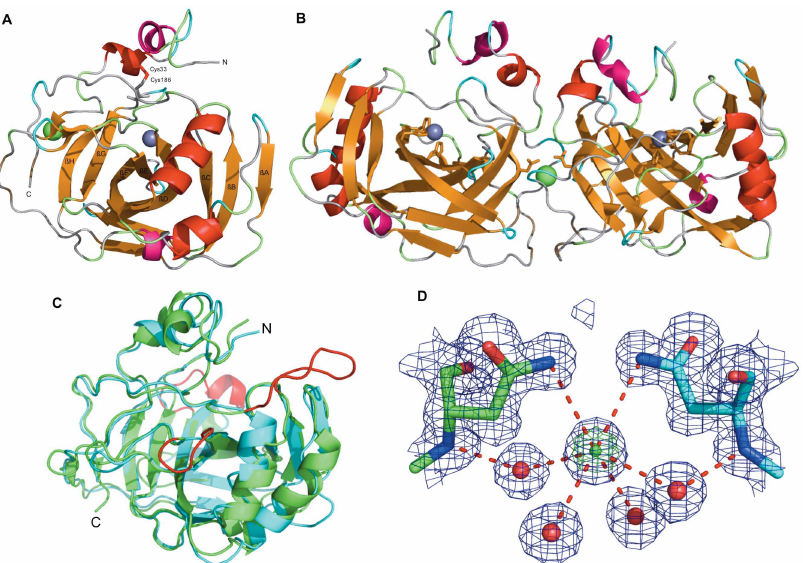
Fig 1. Overall structure of PprCA and structural comparison with prokaryotic and human α –CA. (A) Cartoonrepresentation of the PprCA monomerwith central ten-stranded β -sheetscolored gold. An intra- moleculardisulfidebond that stabilizesthe monomeris shown as stick model. Catalytic zinc ions are shown as gray sphereswhile the chlorideion is shown in green (B) Cartoonrepresentation of the PprCA dimer with α -helices and β -sheetscolored accordingto structural conservation. The dimer interface chlorideion is shown in green. The active site zinc ions are shown as grey spheres. (C) Comparison on PprCA monomerwith hCAII. hCAII is shown in green whilePprCA is shown in blue. Surface loops regions of hCAII are coloredred. (D) Chlorideion coordinationby four water moleculesand Asn 178/ND2from Chain A (green)and ChainB (blue). 2Fo-Fc electron density contoured at 8.0 σ (green)and 1.0 σ